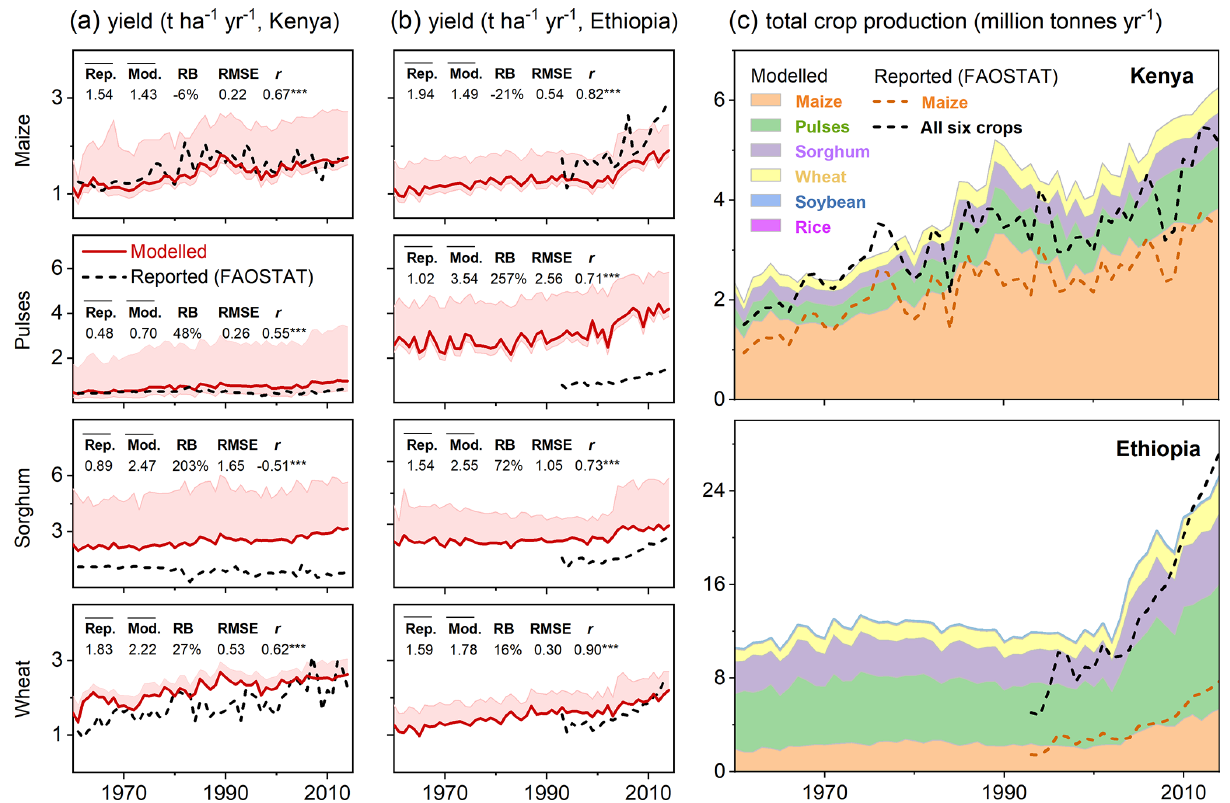
Figure 4. Comparison of modelled and FAO-reported annual crop yields at the country level from 1961–2014 in Kenya (a) , in Ethiopia (b) , and for total crop production (c) . The upper and lower bounds of shade areas in (a) and (b) represent the simulated yields in irrigated and rain-fed conditions, respectively, with their area-weighted aggregated results as given in red solid lines. Rep. and Mod. indicate the reported and modelled yields averaged over FAO-based periods (1961–2014 for Kenya and 1993–2014 for Ethiopia), respectively; RB is relative bias, represented in percent (%); RMSE is root mean square error, with the same unit as yield (tha − 1 yr − 1 ); r is Pearson correlation coefficient, where ∗∗∗ denotes the correlation being statistically significant at the p = 0 . 001